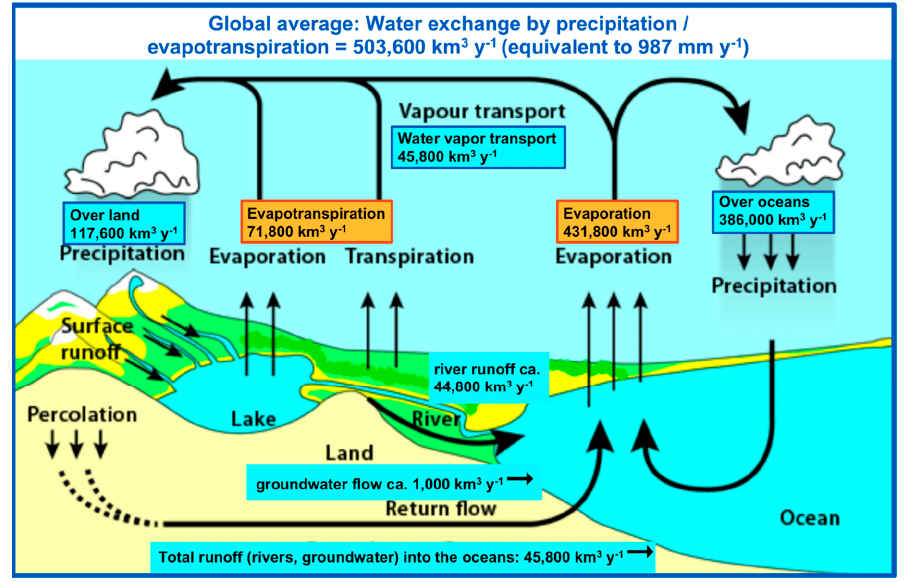
Figure 3. Average water transport/exchange in km 3 per year. Figure modified from [1].